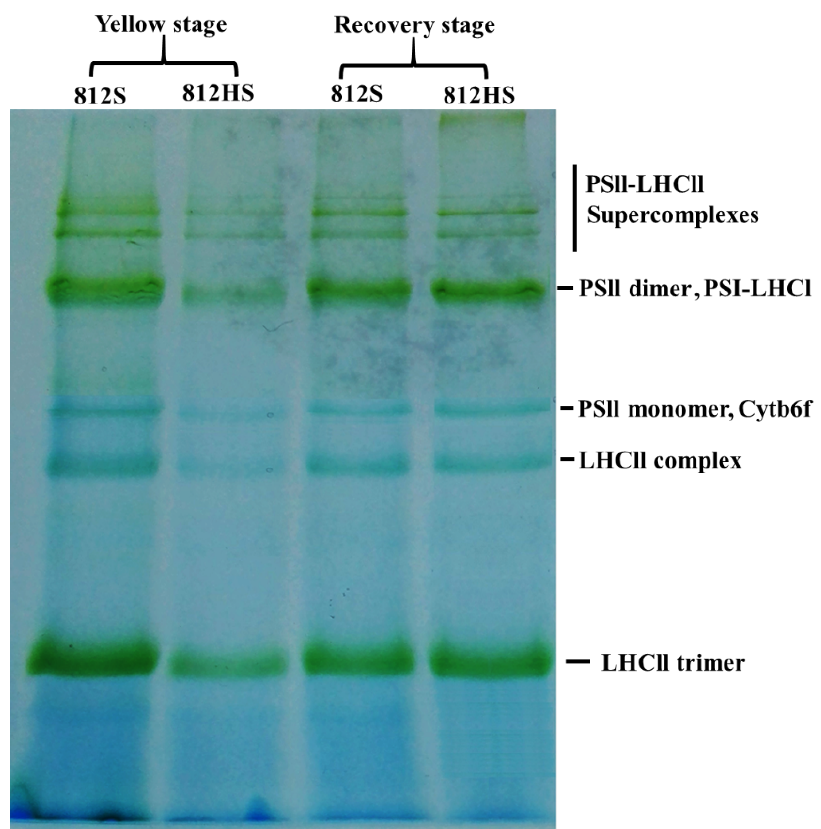
Figure 10. Effects of photooxidation of thylakoid membrane from mutant 812HS and wild-type 812S by BN-PAGE analysis.